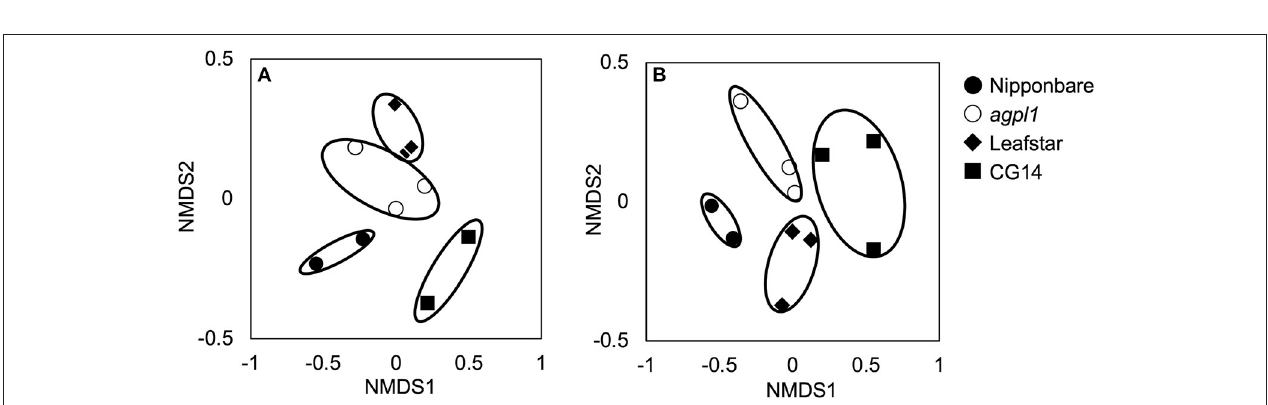
FIGURE 4 | Non-metric multidimensional scaling (NMDS) plots of 16S rRNA libraries (A) and NifH libraries (B) of bacterial communities in stem of four rice genotypes at the heading stage, comparing community dissimilarities (based on Bray–Curtis distances) in the 2018 field experiment among each replicate ( n = 2 or 3). Replication of each genotype ( n = 2 or 3) are indicated for each